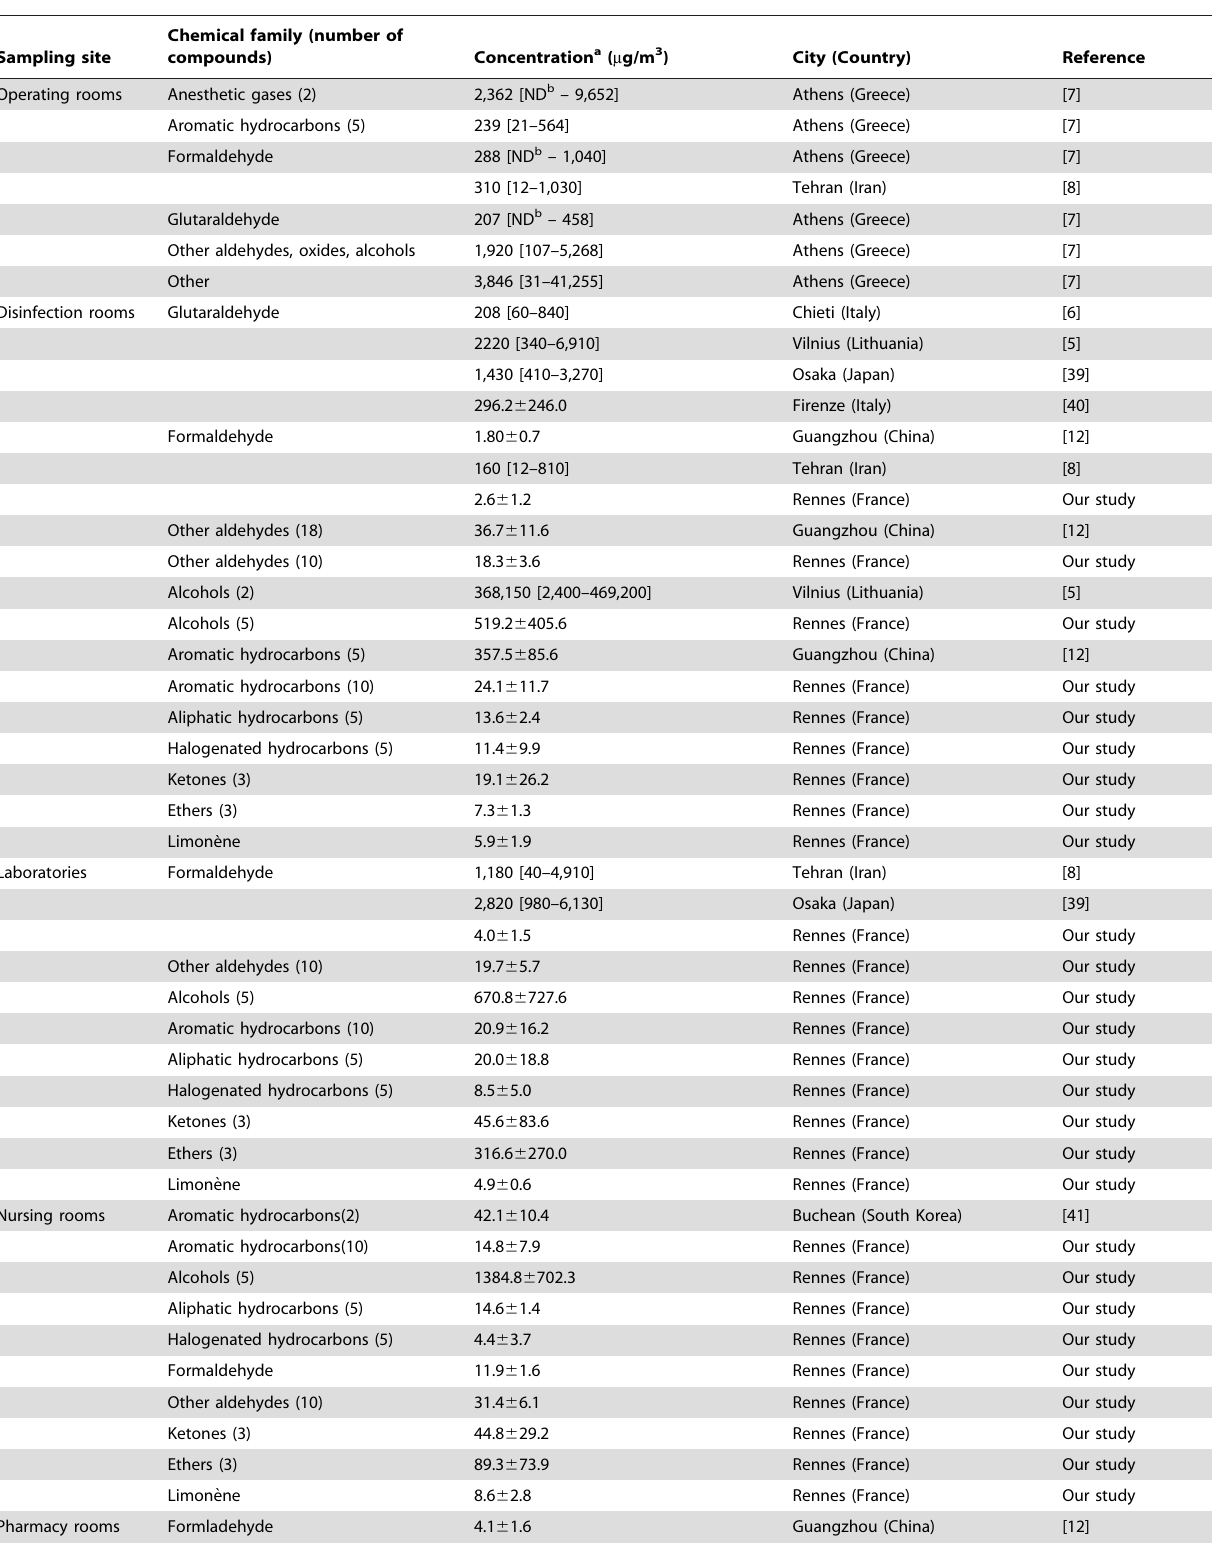
Table 6. Comparison of VOCs concentrations measured with those reported to selected references.